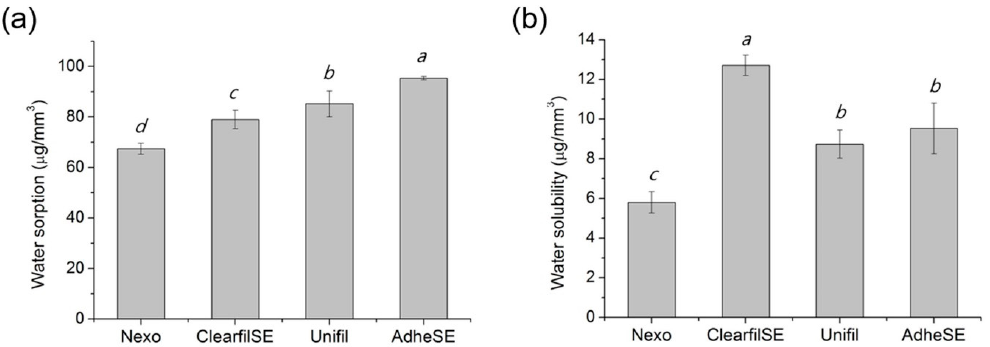
Figure 3. Water sorption ( a ) and solubility ( b ). The same letters mean no significant differences. Raw data are presented in Tables S2 and S3.